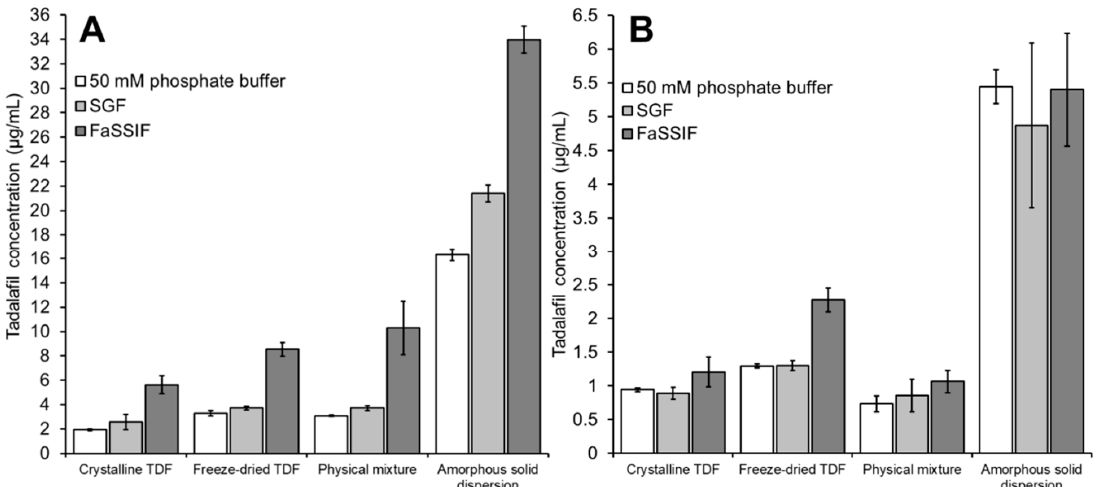
Figure 7. Tadalafil concentration in ( A ) the donor compartment or ( B ) the acceptor compartment after 6 h of incubation using di ff erent media for dispersion of the formulations. The acceptor medium was 1% Vitamin E TPGS in the respective dispersion medium. Data shown as mean ± SD of four replicates. Compared to the large-scale dissolution method, the high-throughput dissolution / permeation method generally yielded a similar outcome in terms of dissolved tadalafil, that is, higher tadalafil concentrations in SGF as compared to phosphate bu ff er, higher tadalafil concentrations from amorphous tadalafil as compared to crystalline tadalafil, superior tadalafil concentrations from the amorphous solid dispersion as compared to all other